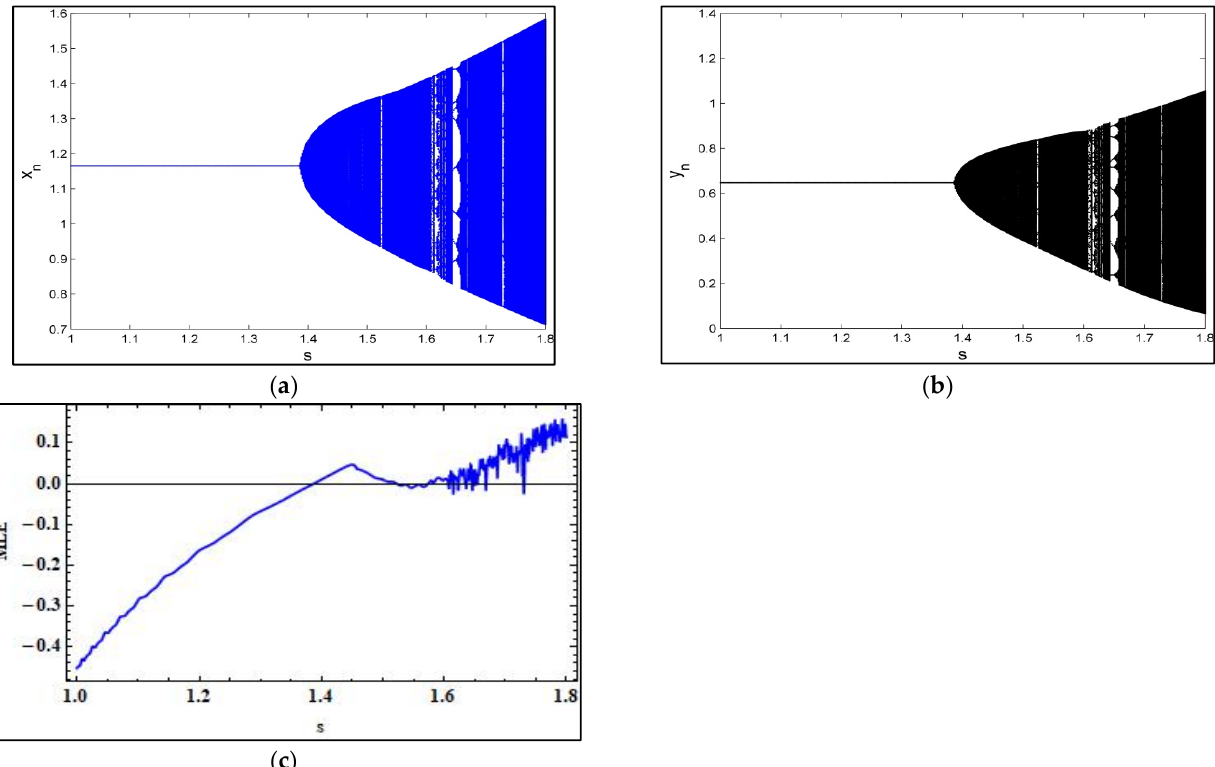
Figure 2. Bifurcation diagrams and maximum Lypunov exponents (MLE) for system (4) with parametric values b = 1.7, a = 2.26, r = 2.4, h = 1.8, k = 1.4 , and s ∈ [ 1,1.8 ] and initial conditions ((cid:1876) (cid:2868) , (cid:1877) (cid:2868) ) = (1.0219,0.567721) : ( a ) bifurcation for (cid:2206) (cid:2196) , ( b ) bifurcation for (cid:2207) (cid:2196) , and ( c ) MLE.